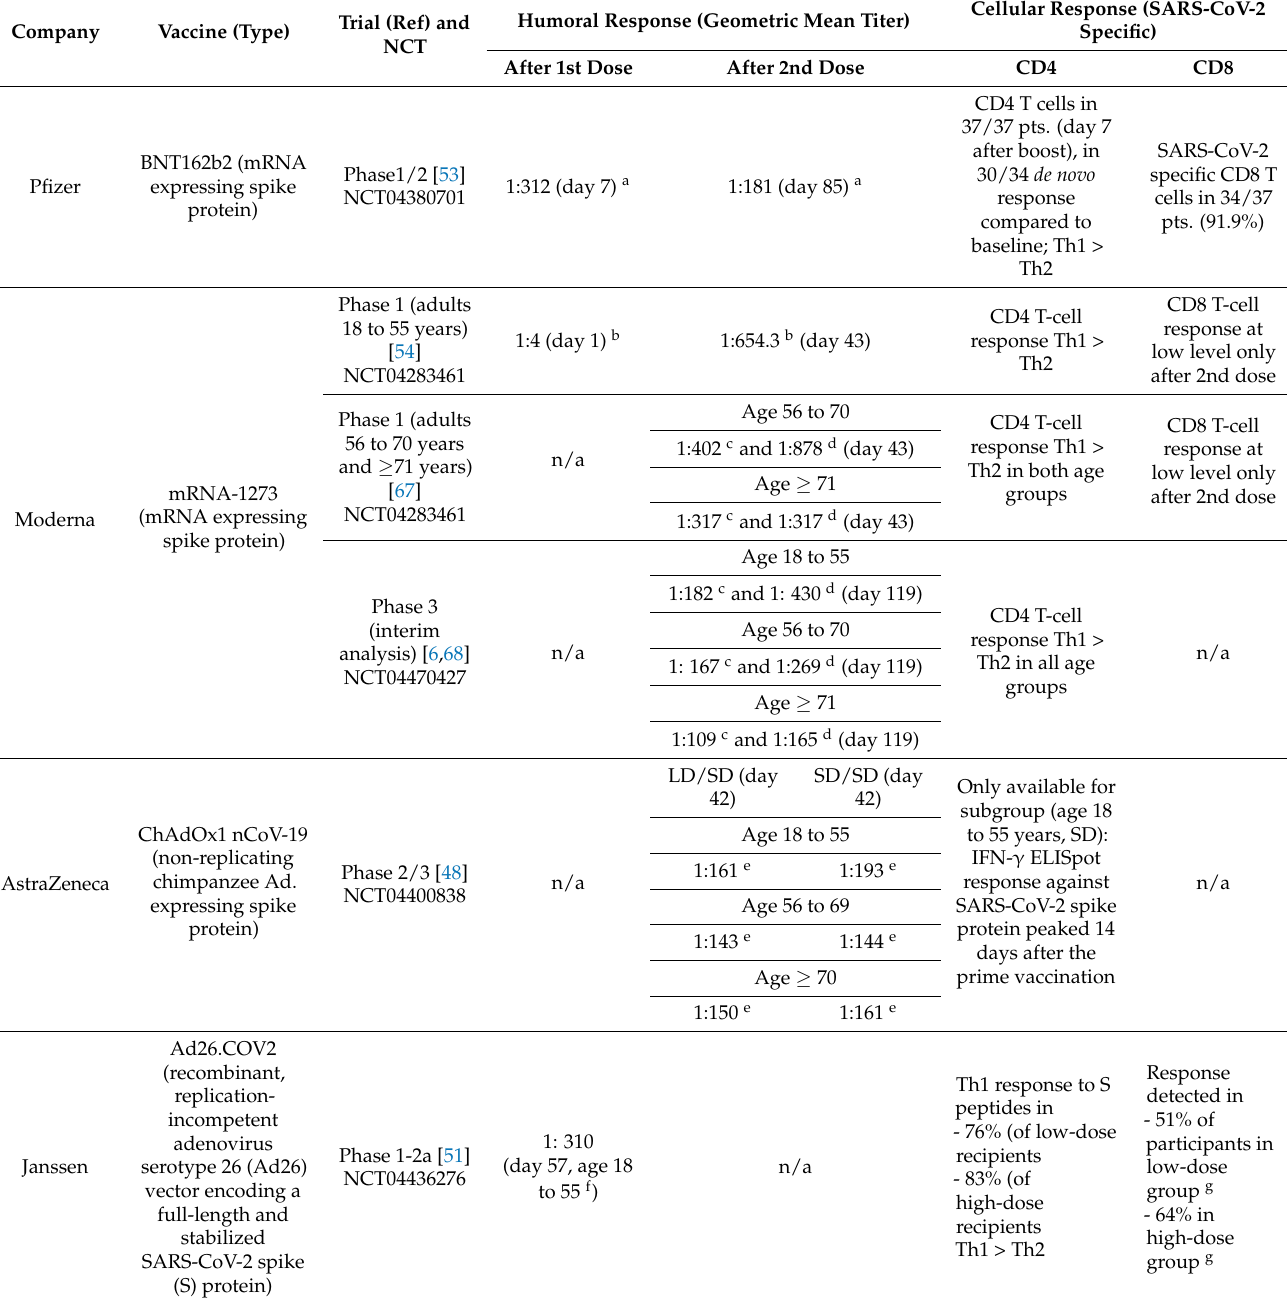
Table 1. Overview of forerunner vaccine